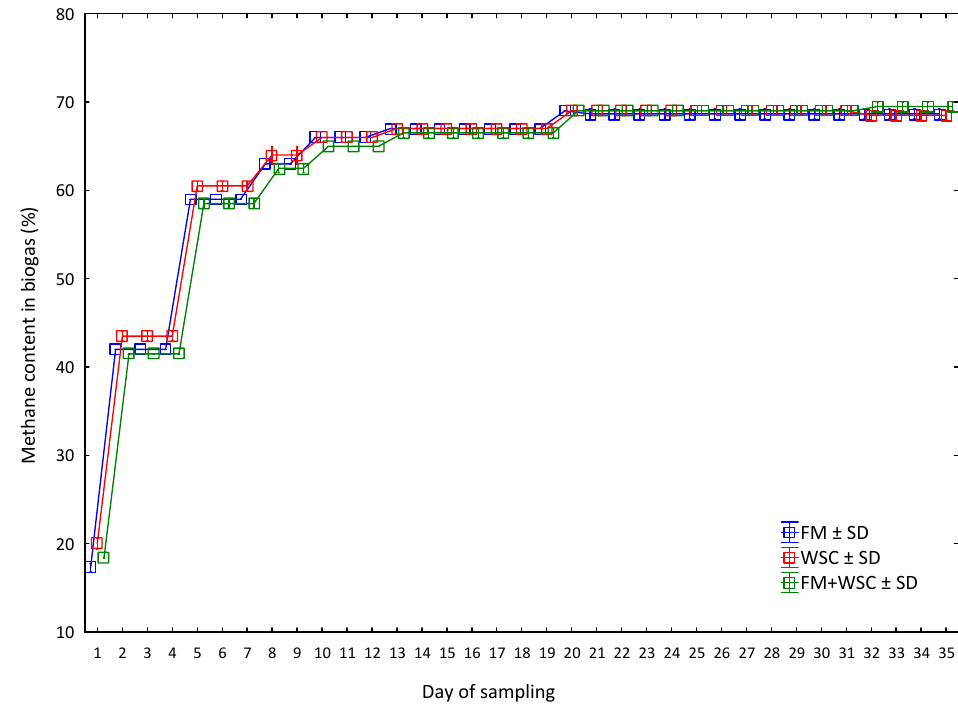
Figure 7. Methane content in biogas during 35 days of the experiment (average values for every day of measurement (n = 3) for one measurement, ± SD). FM—fodder mallow; WSC—white sweet clover.